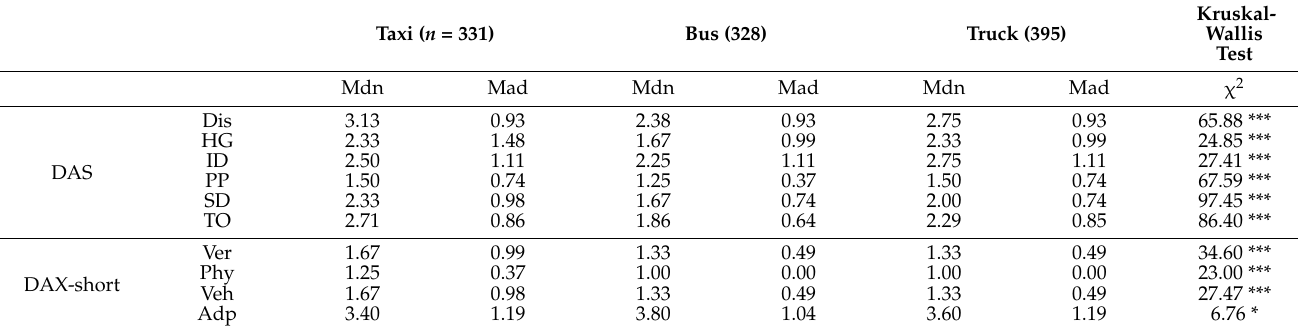
Table 7. Descriptive statistics and Kruskal–Wallis tests for study variables across professional driver